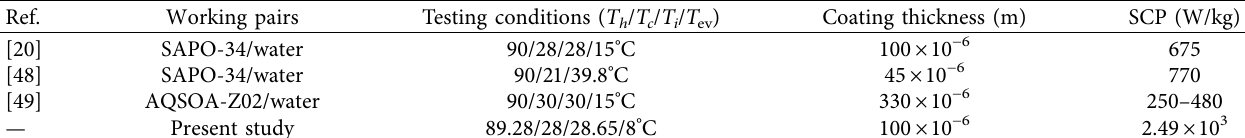
Table 5: Comparisons of SAPO-34 (AQSOA-Z02)/water pairs.